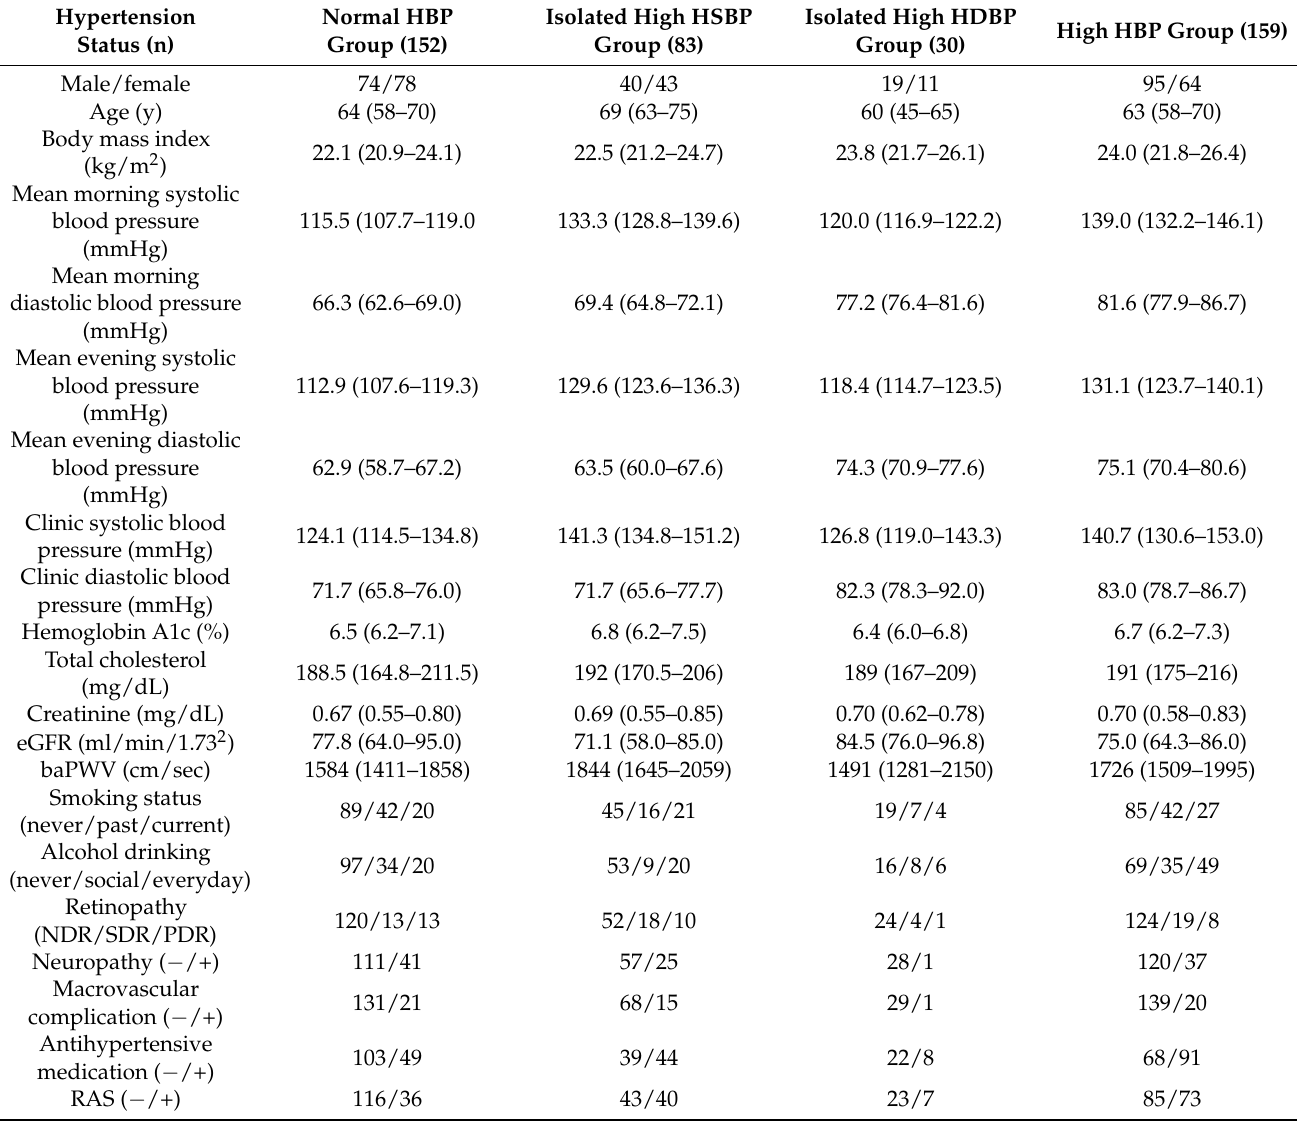
Table 2. Characteristics of patients according to the 4 groups based on HBP levels.